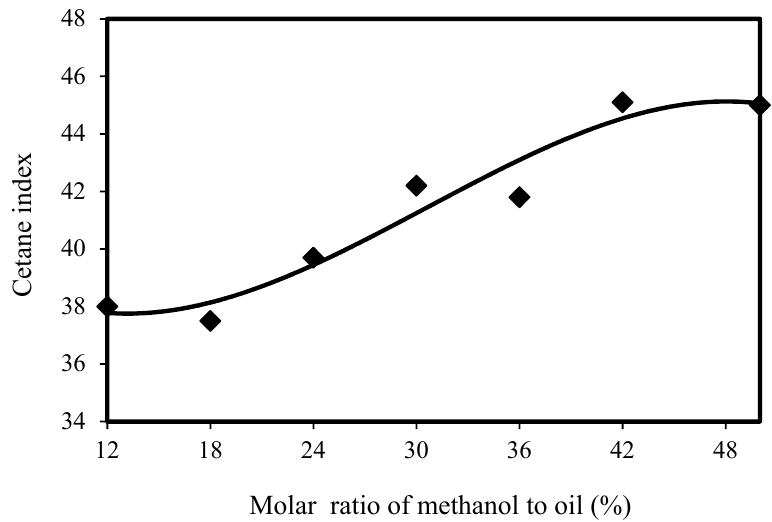
Figure 5. Cetane index of the biodiesel produced with various molar ratios of methanol to high-acid oil through supercritical-methanol